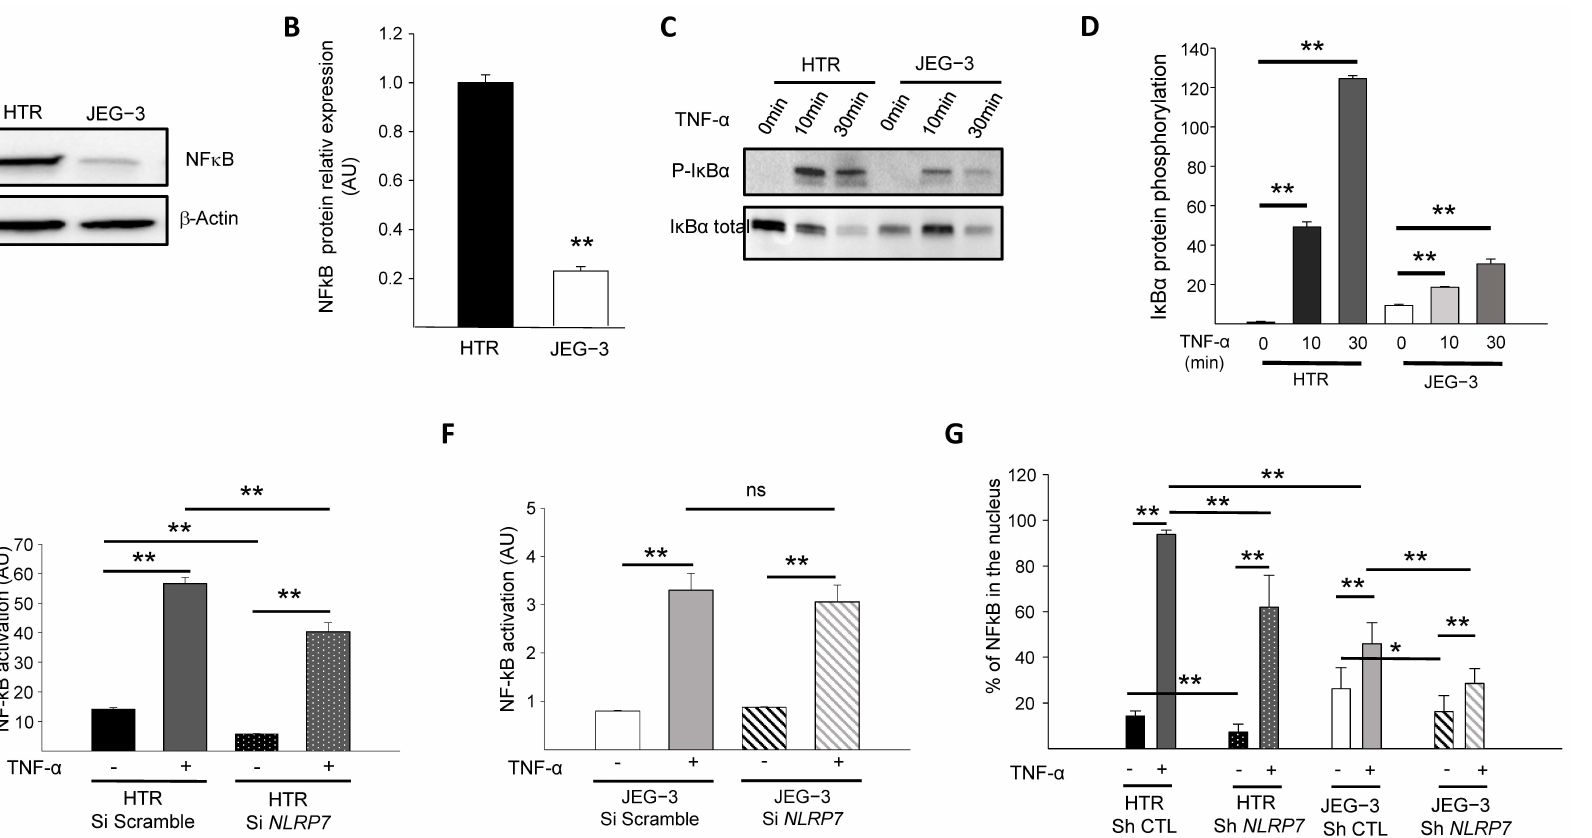
Figure 2. Comparison of the activation of the NF- κ B pathway by TNF- α in HTR8/SVneo and JEG-3 cell line silenced for NLRP7 . ( A ) reports a comparison of NF- κ B protein levels in HTR8/SVneo and JEG-3 cells. ( B ) reports a quantification of the NF- κ B protein levels in HTR8/SVneo and JEG-3 cells ( n = 3); ** p < 0.01. Standardization of protein signals was performed using antibodies against β -Actin. ( C ) reports a comparison of the phosphorylation of I κ B α protein in HTR8/SVneo and JEG-3 cells treated or not with TNF- α (10 ng/mL) for the times indicated. ( D ) reports a quantification of the ratios of phosphorylated I κ B α protein ( n = 3); ** p < 0.01. ( E ) reports a comparison of the basal and TNF- α activated NF- κ B pathway in HTR Si Scramble and HTR Si NLRP7 ( n = 4); ** p < 0,01. ( F ) reports a comparison of the basal and TNF- α activated NF- κ B pathway in JEG-3 Si scramble and JEG-3 Si NLRP7 ( n = 4); ** p < 0,01; ns: not significant. ( G ) reports a High Content Analysis (HCA) of the NF- κ B nuclear translocation experiment. Results are reported as the percentage of NF- κ B present in the nucleus ( n = 6); * p < 0.05, ** p <